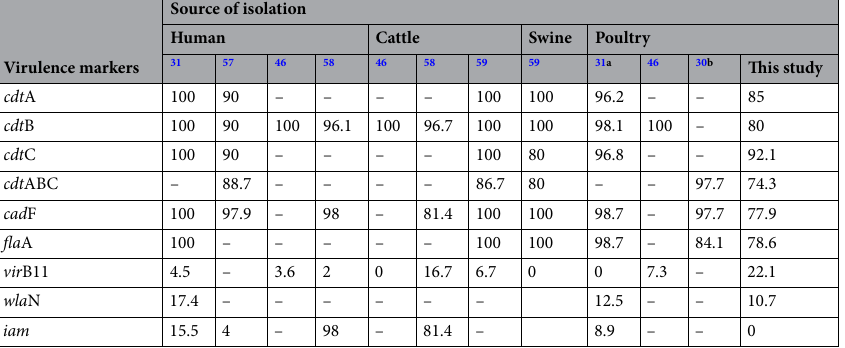
Table 4. Relative Frequencies (%) of virulence markers in Campylobacter jejuni strains isolated from several sources found in other publications compared to the results of this current study. a Results for strains isolated from poultry carcasses only. b Results for strains isolated between 2015 and 2016